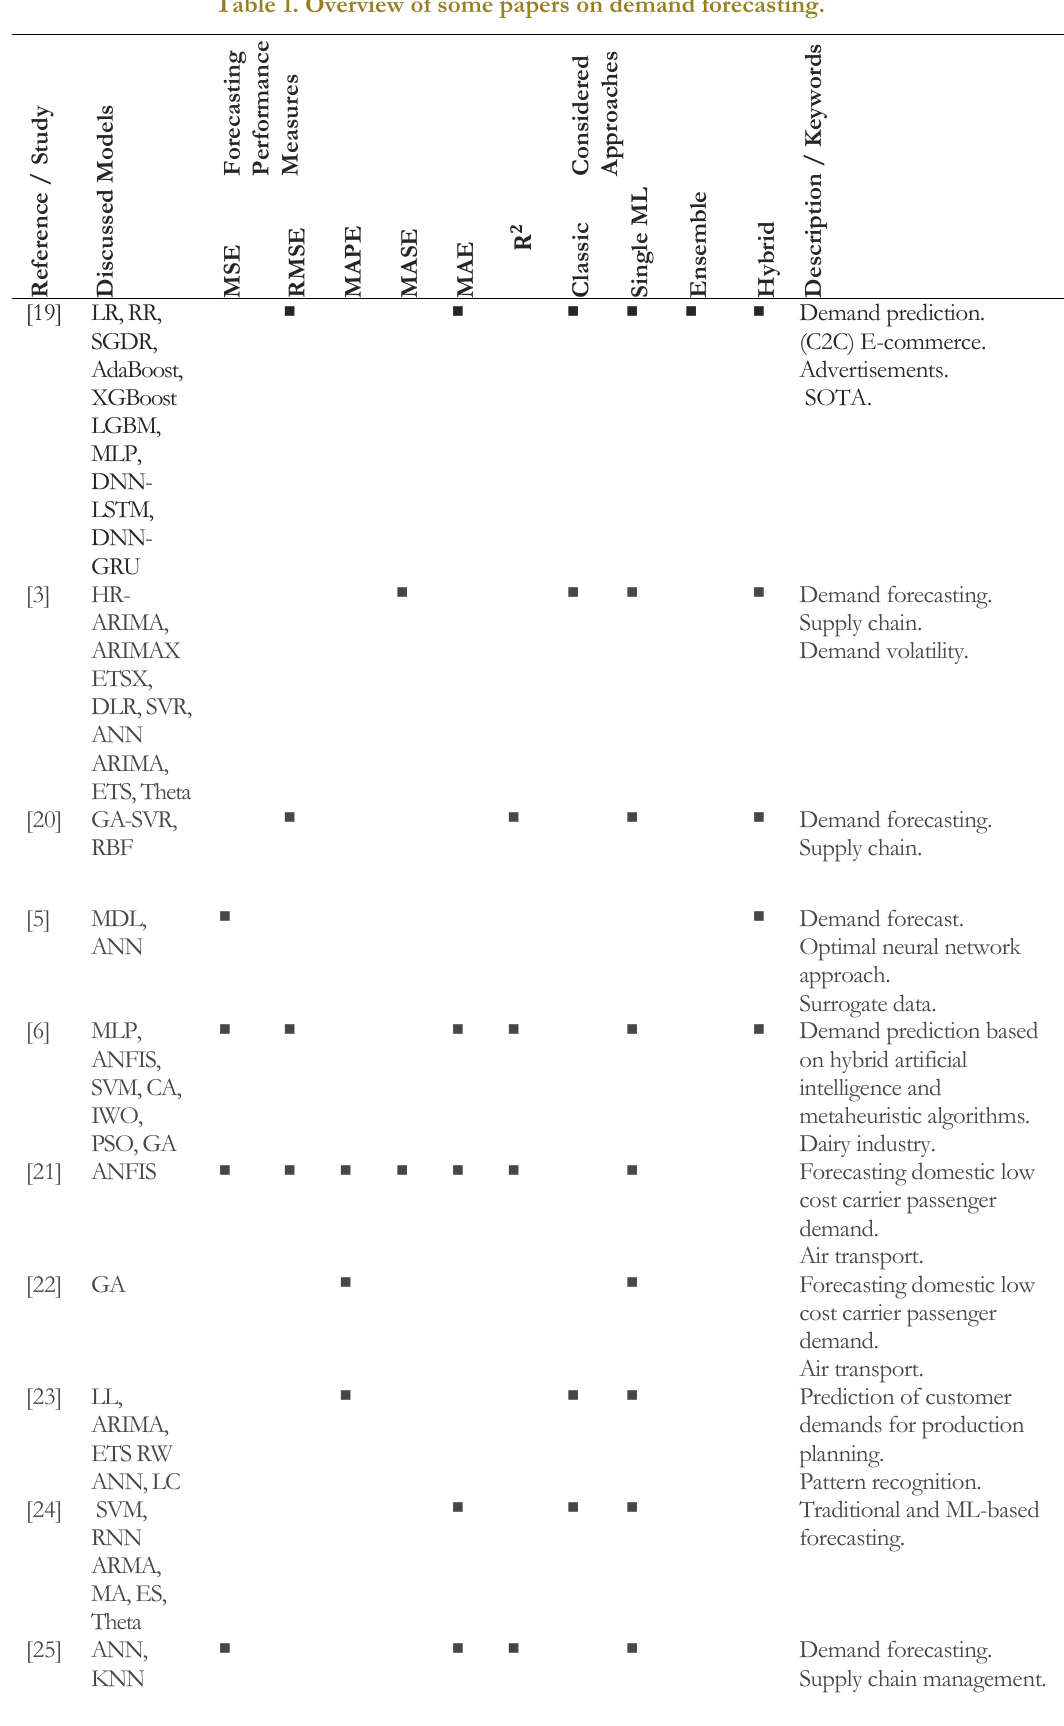
Table 1. Overview of some papers on demand forecasting.